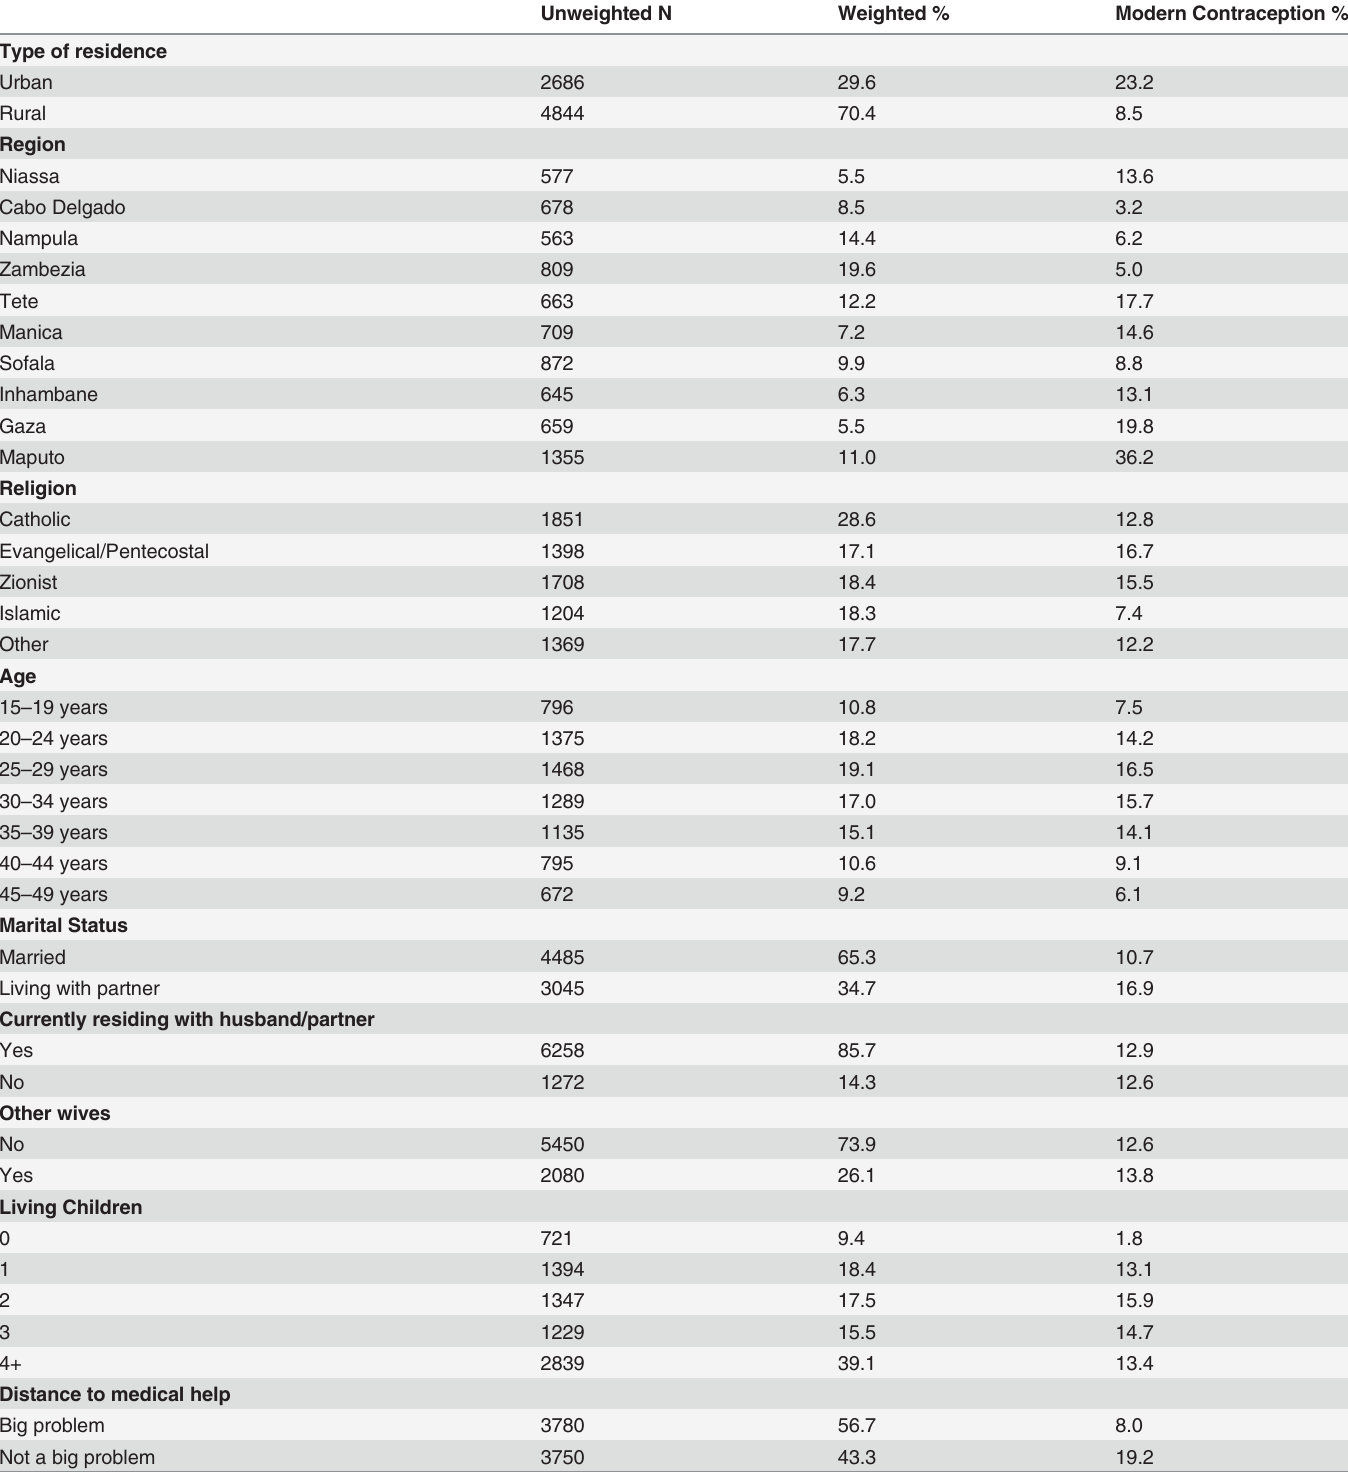
Table 1. Sample description and modern contraceptive prevalence (Mozambique DHS